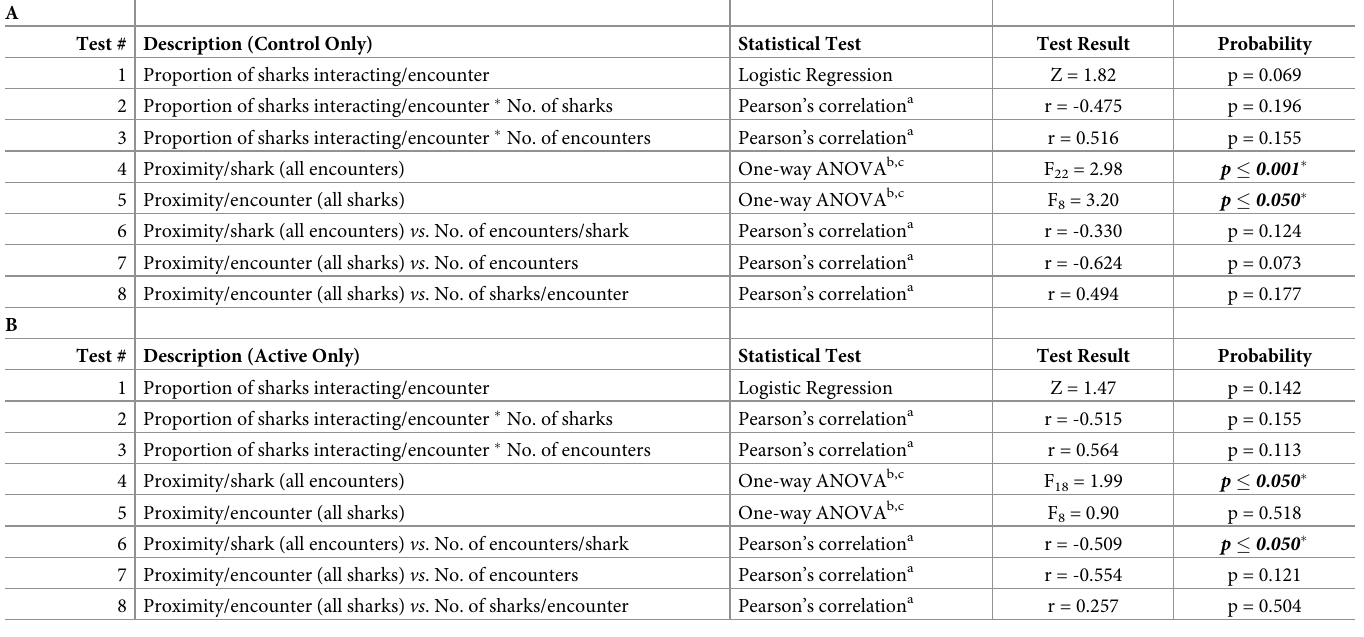
Table 3. Comparison of the behavioural response of C . carcharias between individuals, and between encounters, during control (A) and active (B) trials. Justifica- tion for the tests used is provided below. Test # Description (Control